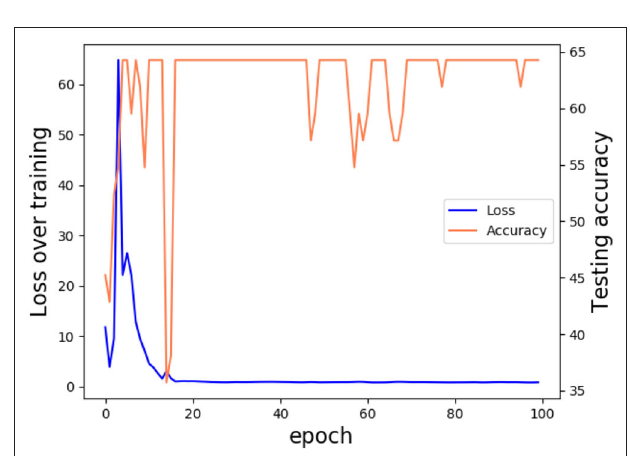
FIGURE 7 | Loss and testing accuracy curve. Trained in 100 epochs, our model got 64.29% accuracy and the loss rate stabilized at around